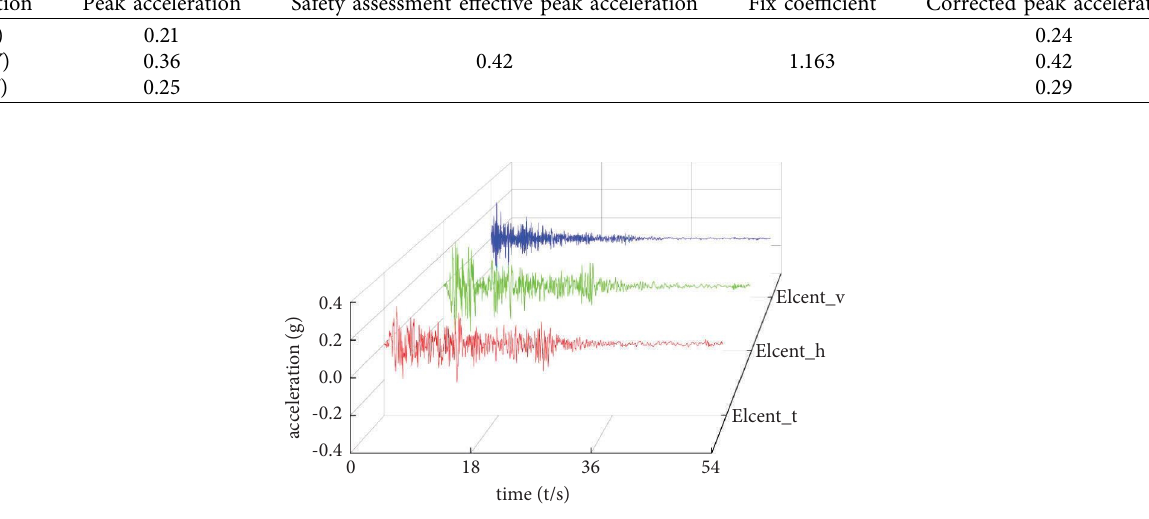
Figure 5: Corrected El Centro 3D seismic